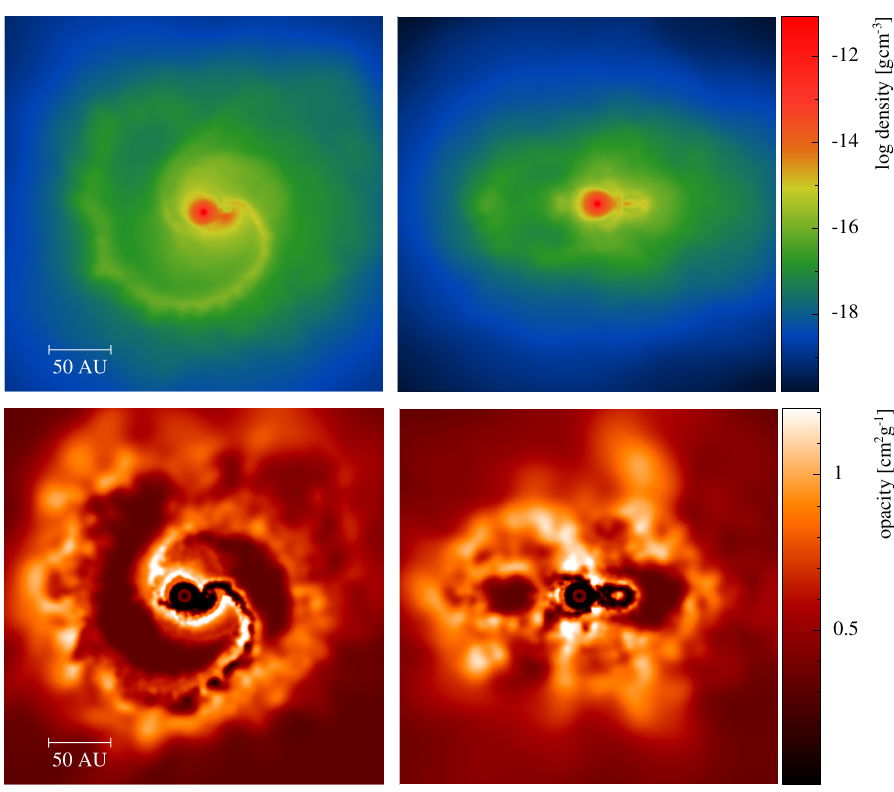
Fig. 3. Density (top) and opacity (bottom) cross-sections of model M1 in the binary orbital plane (in the xy plane, left panels) and perpendicular to it (in the xz plane, right panels) after 2.5 orbital periods. The out(cid:13)ow geometry exempli(cid:12)es WRLOF systems in which the dust forms beyond the Roche-lobe (i.e., R dust =R L ; 1 (cid:21)